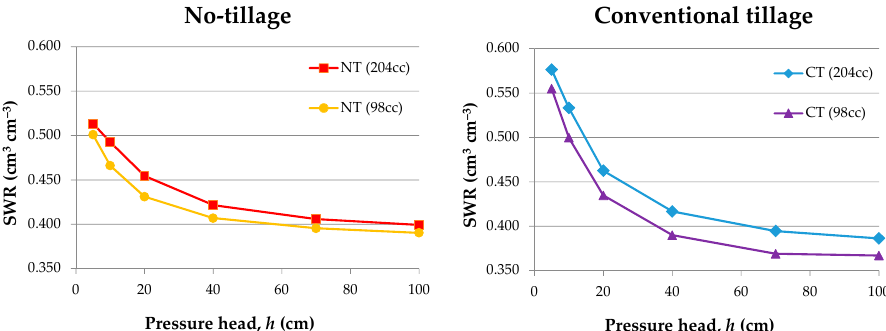
Figure 6. Soil water retention (SWR) as a function of soil water pressure head ( h ) obtained using small (98 cc) and large (204 cc) soil cores before sowing, under NT and CT in Foggia.